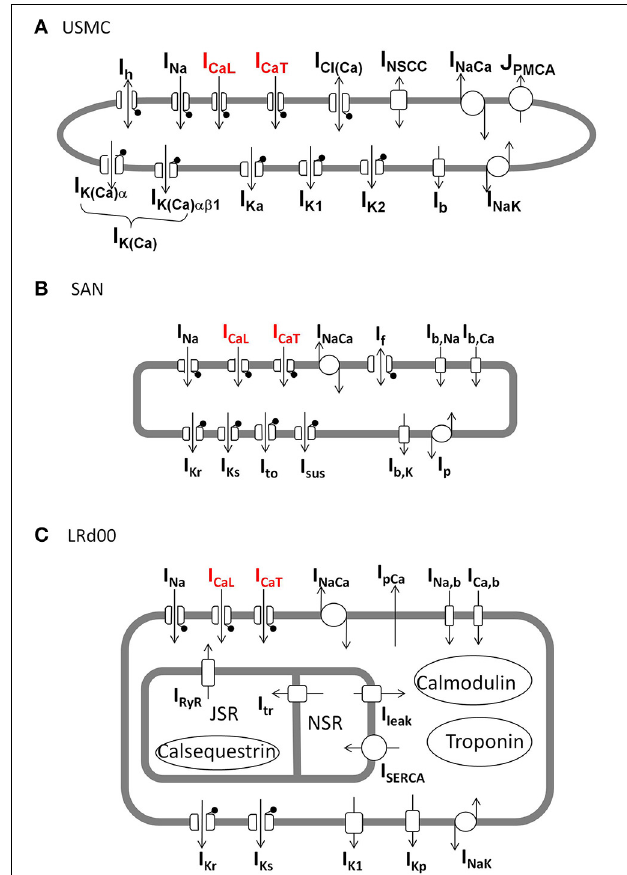
FIGURE 1 | Schematic diagrams of the ionic currents in each of the three cell models. (A) Uterine smooth muscle cell model (USMC) (Tong et al., 2011), (B) rabbit sinoatrial nodal cell model (SAN) (Garny et al., 2003), (C) modified guinea pig ventricular cell model (LRd00) (Faber and Rudy, 2000). The lollipop sign indicates channels that are voltage-gated. The L-type Ca channel and T-type Ca channel, carrying I CaL and I CaT , respectively, are indicated in